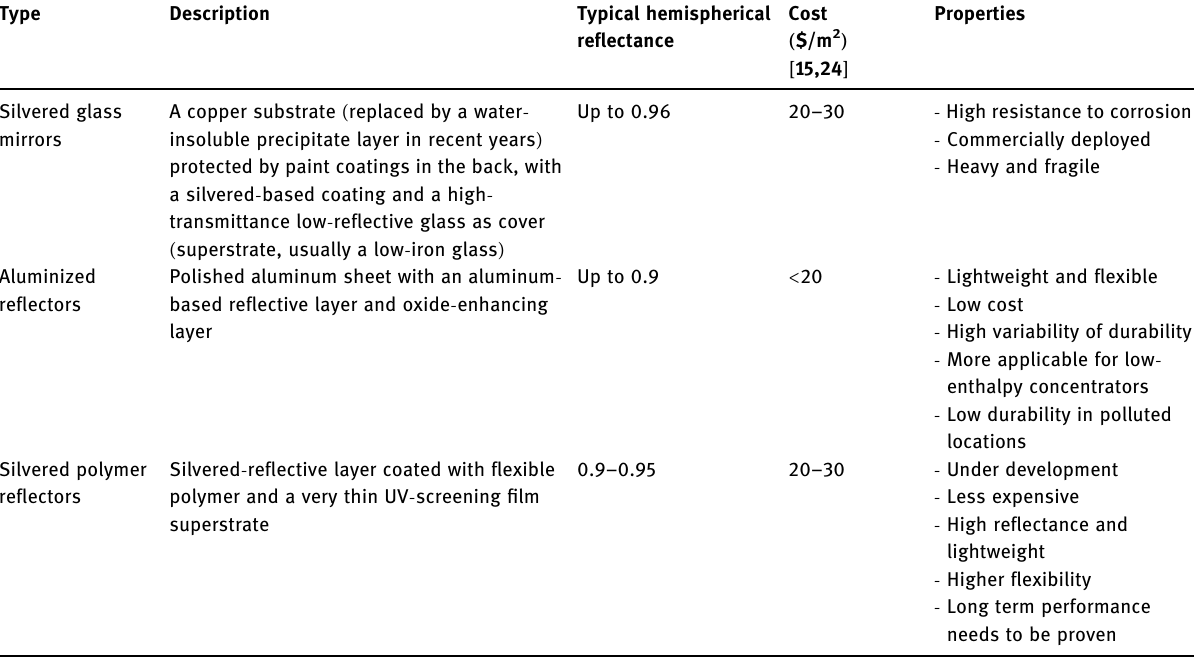
Table 3: Types of mirrors with coatings [ 8 – 14